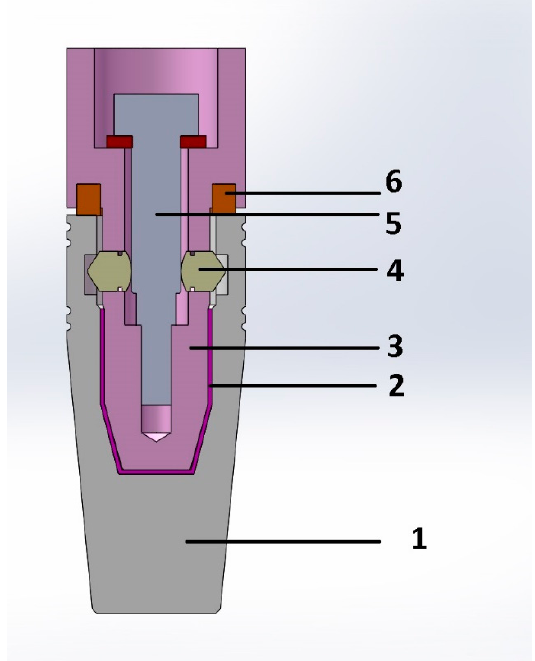
Figure 1. Initial drawing of the implant concept (SolidWorks): ( 1 ) Implant body, ( 2 ) cushioning mechanism, ( 3 ) abutment, ( 4 ) locking pins, ( 5 ) implant screw, ( 6 ) O-ring (cushioning mechanism).